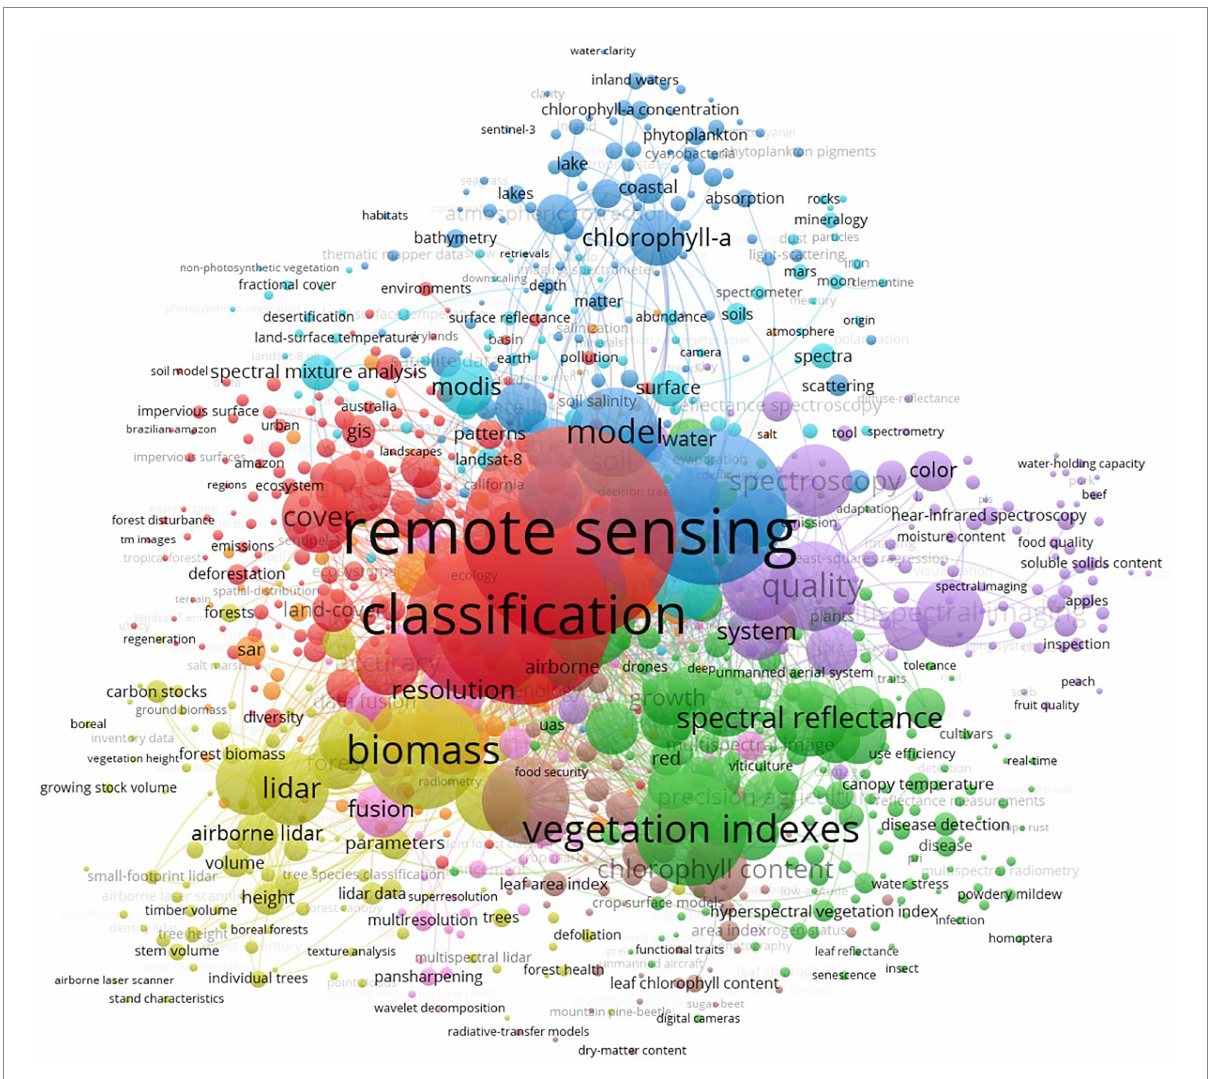
resolution. From the top 20 keywords given on Table 4, cluster